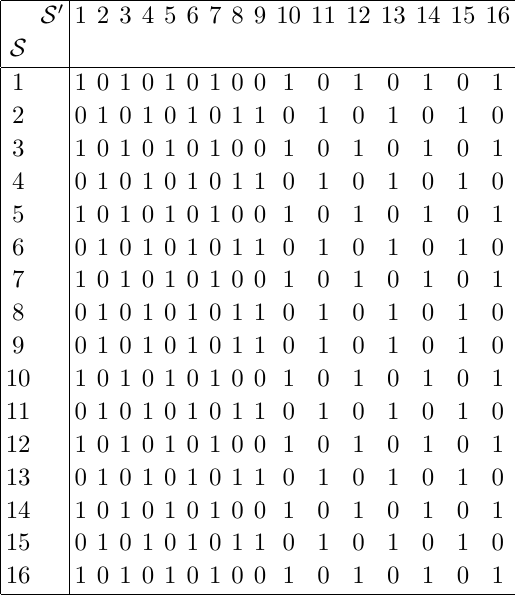
(cid:2) P with di(cid:11)erent boolean factors. [5] [5]